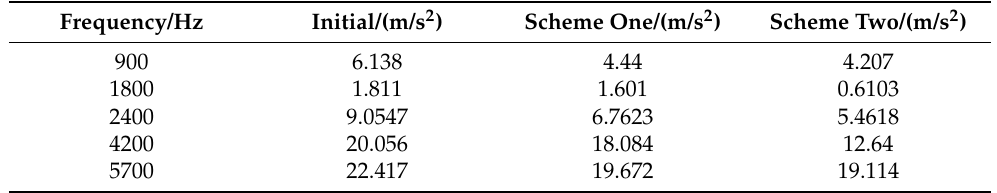
Table 4. Vibration acceleration amplitude at major frequency points.